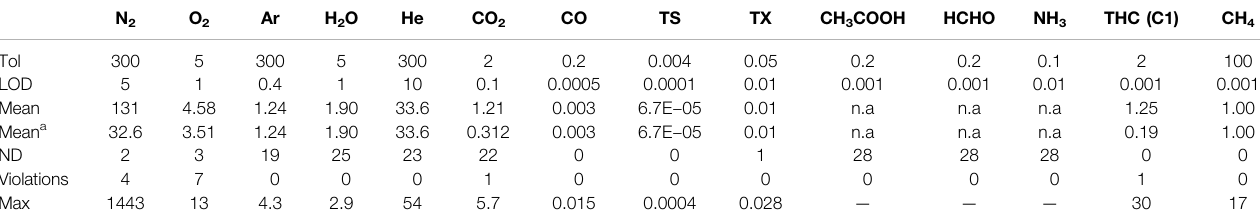
TABLE 5 | Aggregated analytical results from the 28 gas